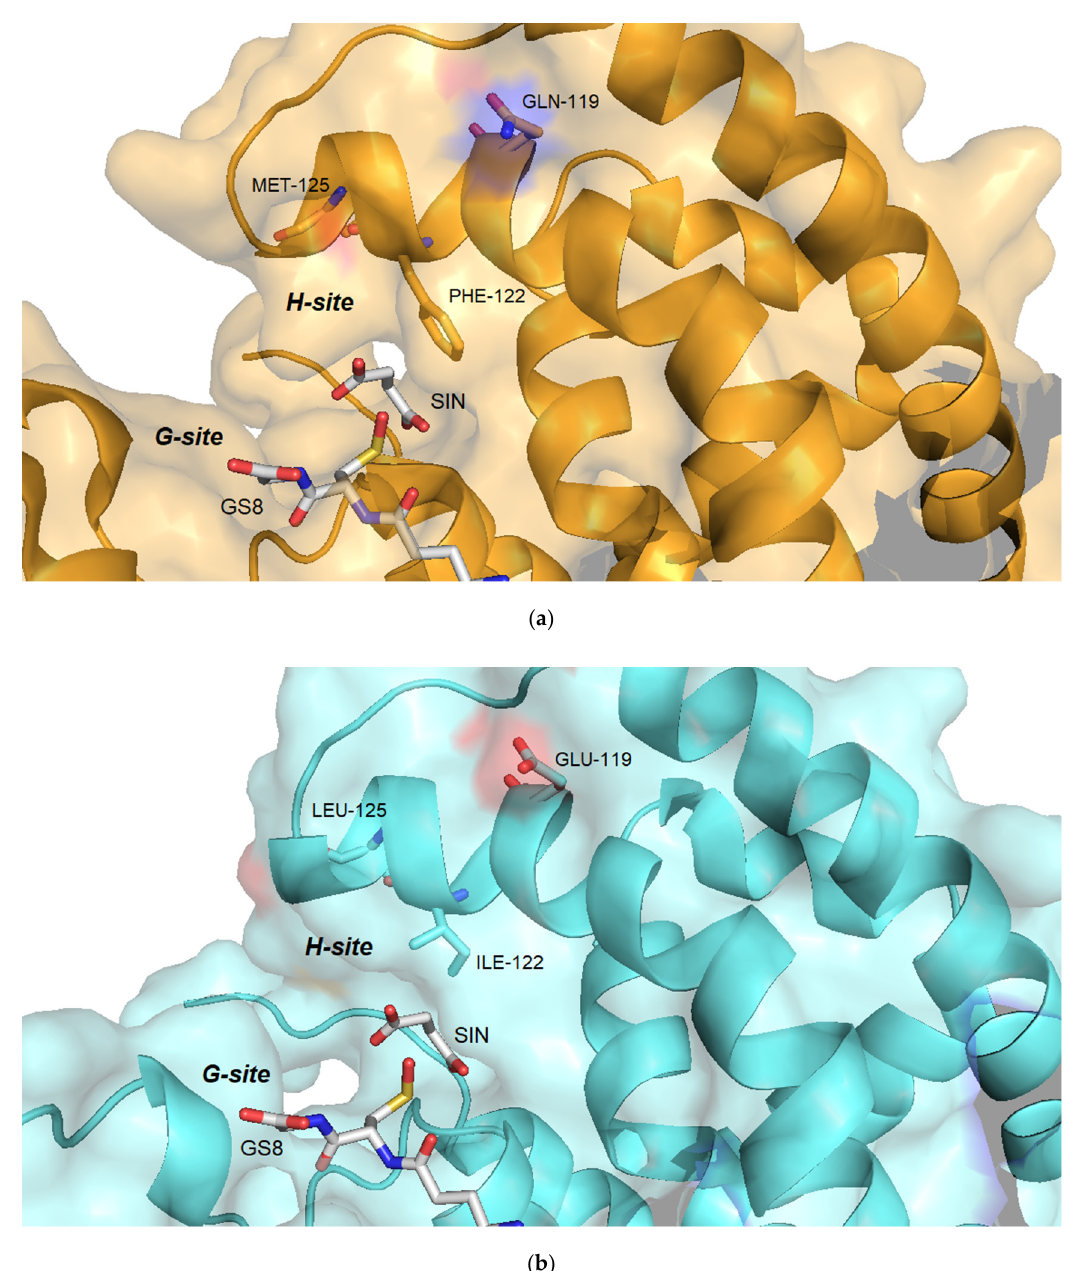
Figure 9. Amino acid residues at positions 119, 122 and 125 in the H-site of Am GSTF ( a ) and sh155 ( b ). The mutations in the sh155 are: Gln119Glu, Phe122Ile and Met125Leu. The succinic acid (SIN) and glutathione sulfenic acid (GS8) molecules bound to the Am GSTF structure are shown as sticks and colored according to the atom type. The figures were created with PyMol [61].